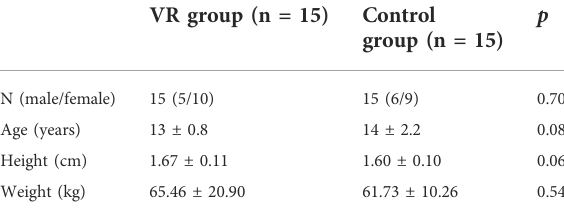
TABLE 2 The baseline characteristics of the